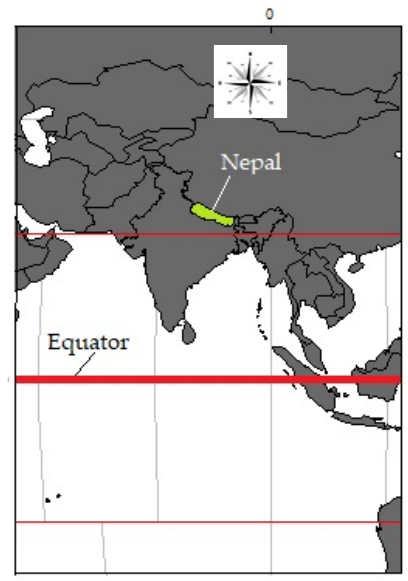
(b)Fig. 1. Geographic location of Nepal in Fig. 1: Geographic location of Nepal in Asia